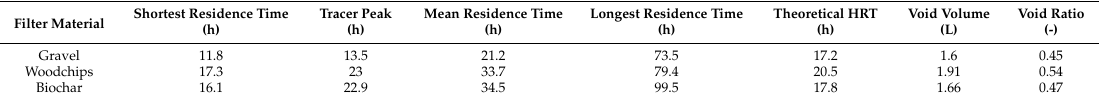
Table 2. Hydraulic characteristics of the different filter materials. The porosities of water-saturated biochar and woodchips were used to calculate the theoretical hydraulic retention times (HRTs). HRTs were calculated from the storage reservoir to effluent sampling, including water residence time in tubes.